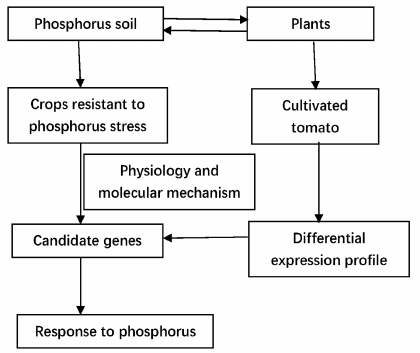
Figure 8. A hypothetical model of identification of SlPAP genes related to P stress using bioinformatic